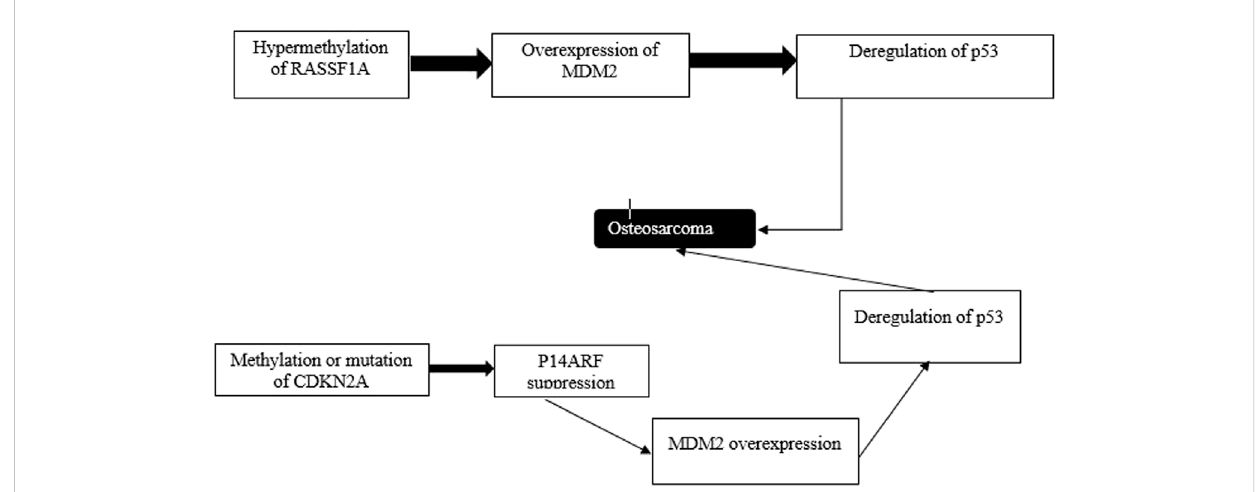
FIGURE 7 Atypical ferroptosis results fromp53 deregulation. Epigenetic eventscontributeto theprogressionofinduction ofoxidation. Geneswhose activities are modulated by p53 or p53 ’ s target genes, including RSSF1A and CDKN2A are silenced via methylation.